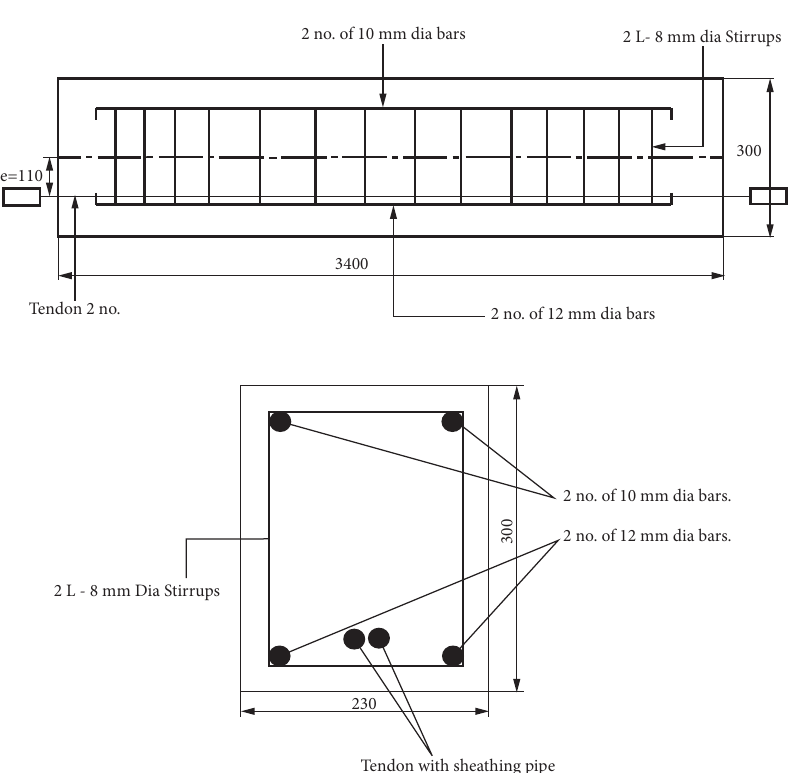
Figure 1: Beam reinforcement